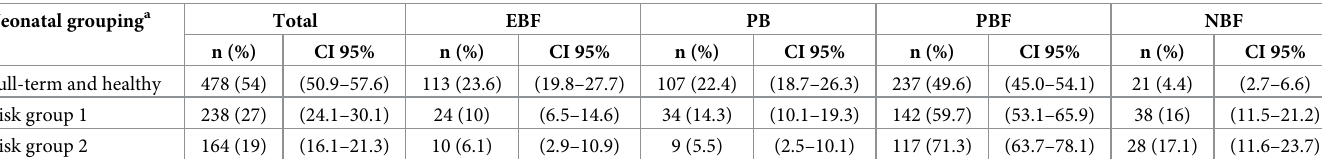
Table 2. Prevalence of breastfeeding at six months of life by risk neonatal profile in a referral center for high-risk infants, Rio de Janeiro, RJ, Brazil, 2018. Neonatal grouping a